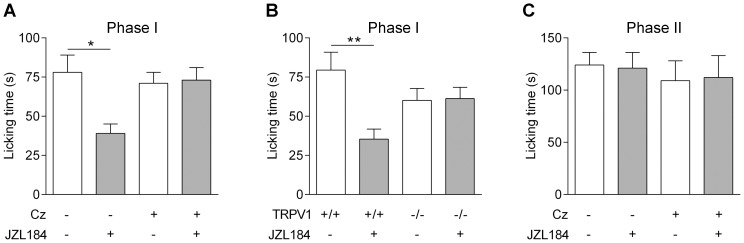
The monoacylglycerol lipase inhibitor JZL184 produces TRPV1-mediated antinociception.Intraplantar injection of formalin (2.5%) into the mouse paw produced a biphasic nociceptive response. (A) Intracerebroventricular (i.c.v.) injection of the monoacylglycerol lipase inhibitor JZL184 (10 nmol) 10 min before formalin injection produced antinociception in the first phase response and this effect was prevented by i.c.v co-administration of 10 nmol capsazepine (Cz). (B) The antinociceptive effect of JZL184 on the first phase of the formalin test was lost in TRPV1 knock-out mice. (C) The second nociceptive phase of the formalin response was unaffected by JZL184 (10 nmol) given i.c.v. 10 min after the intraplantar injection of formalin. Data are presented as mean ± s.e.m (n = 8–9). Kruskal-Wallis one-way ANOVA followed by Dunn's post hoc test was used for comparing groups of data.*P<0.05.